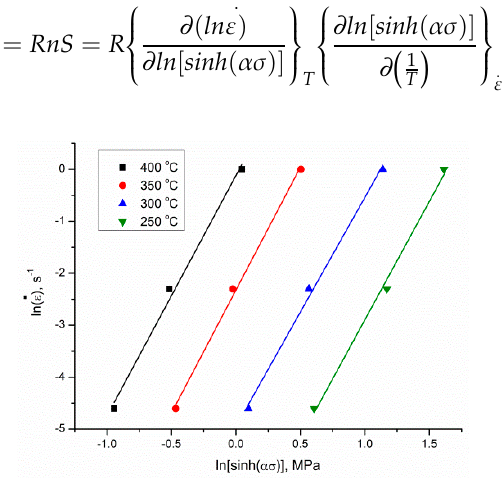
. ε ) and ln [ sinh ( ασ )]